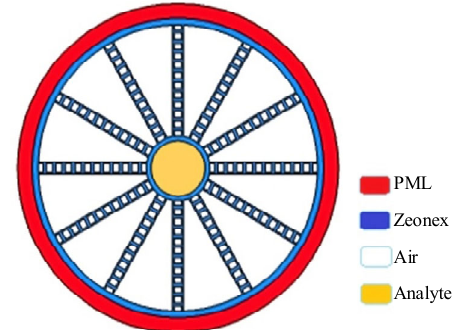
Fig. 1 Cross-sectional view of the proposed tuberculosis